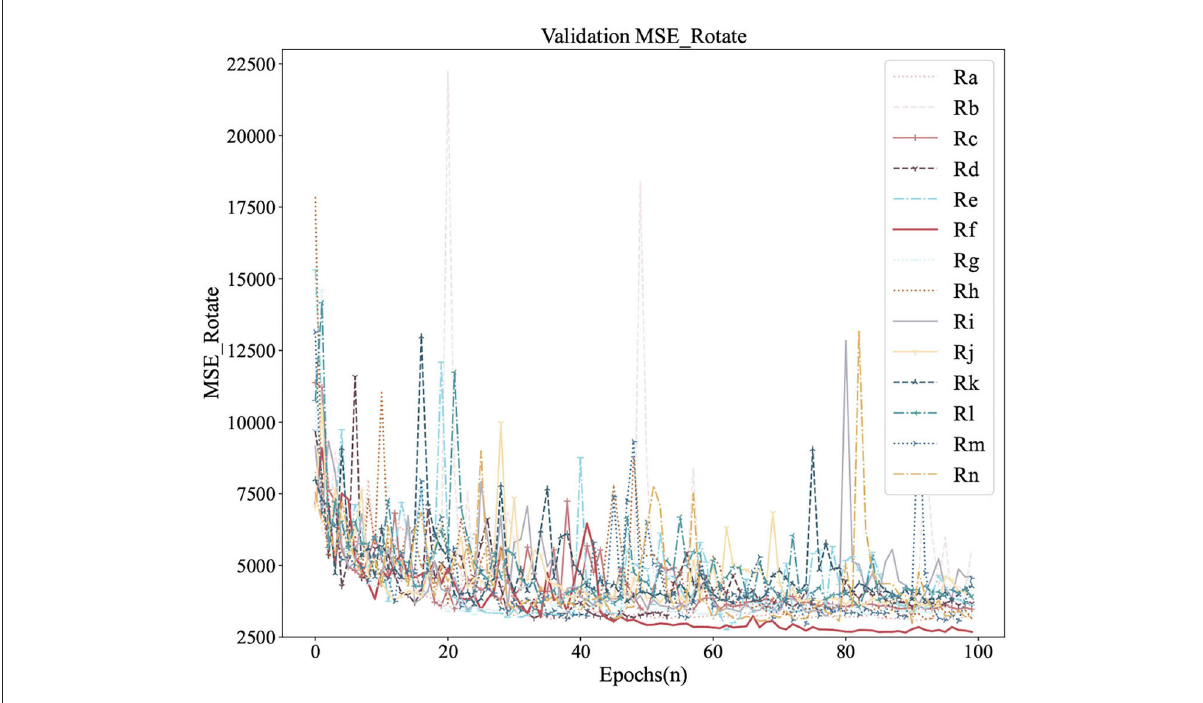
FIGURE7 Comparison of MSE_Rotate among 14 regressors on the validation.